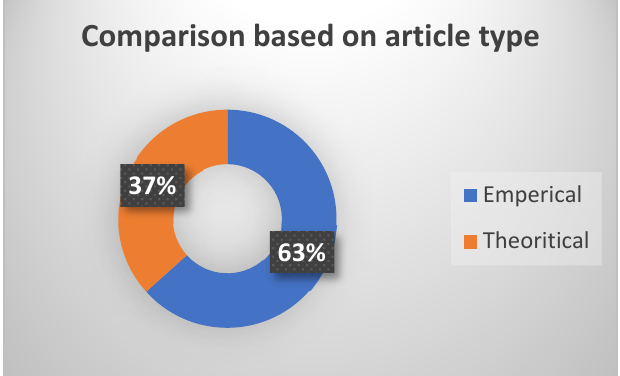
Figure 5. Comparison based on article type.